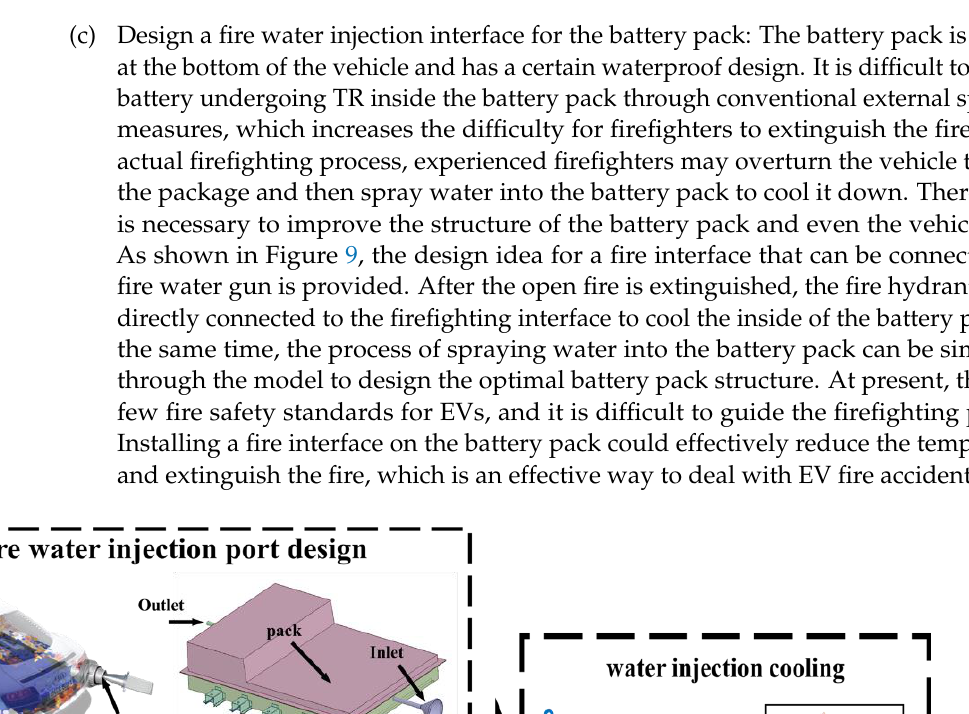
Figure 8. Structure design of a no-fire battery pack.